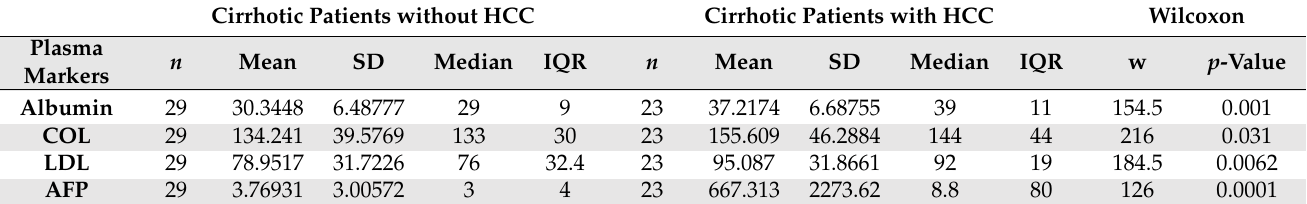
Table 3. Comparison of plasma biochemical markers between cirrhotic patients and cirrhotic patients with HCC (only statistically significant differences are